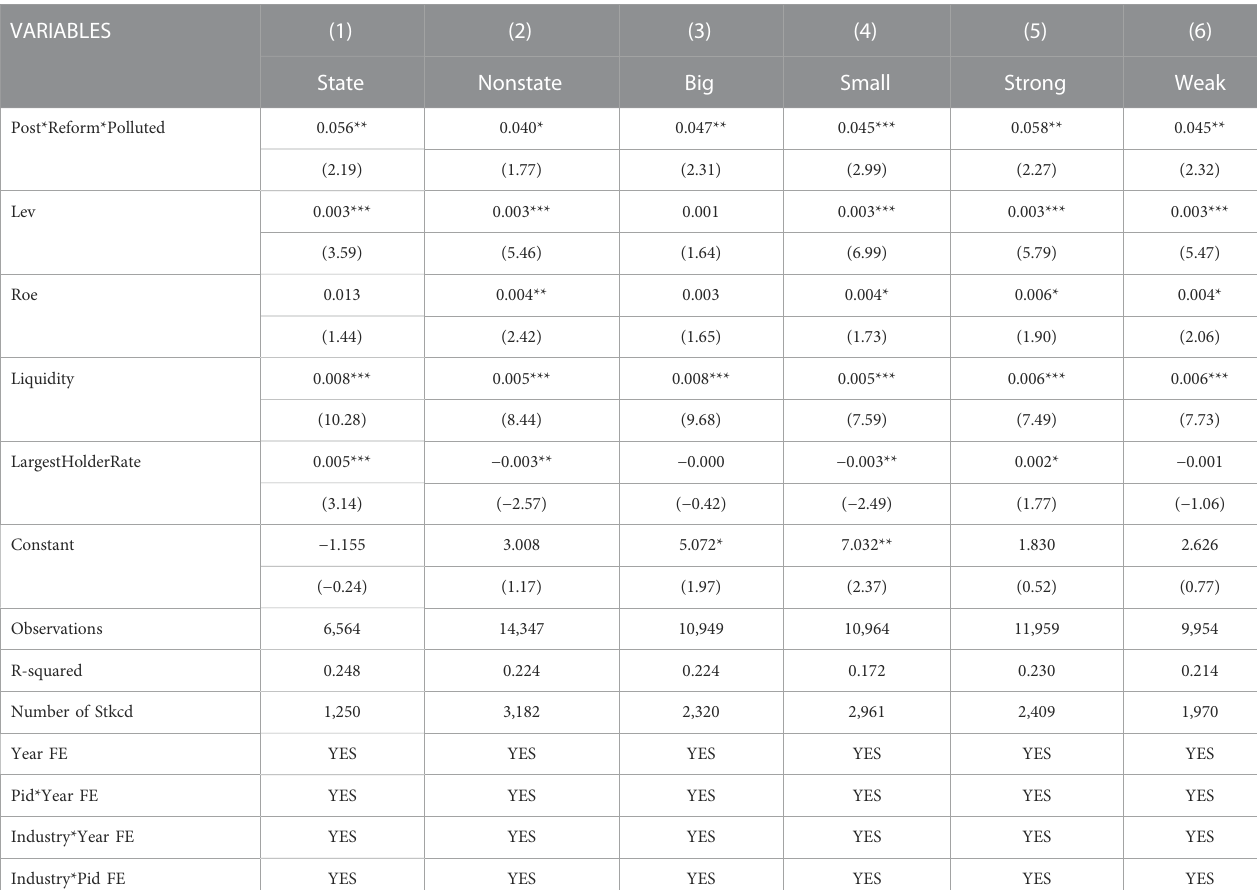
TABLE 5 Heterogeneity analysis.